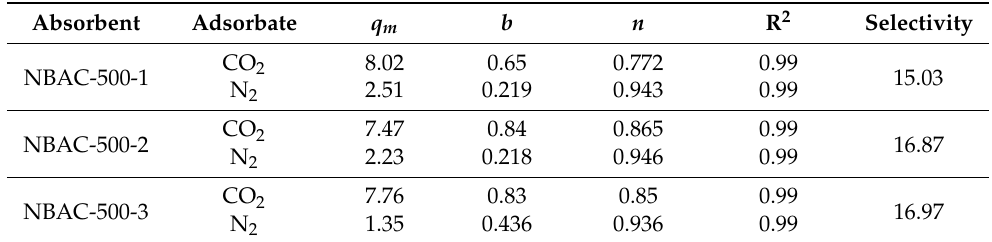
Table 4. Fitting results and adsorption selectivity for NBACs synthesized at 500 ◦ C.